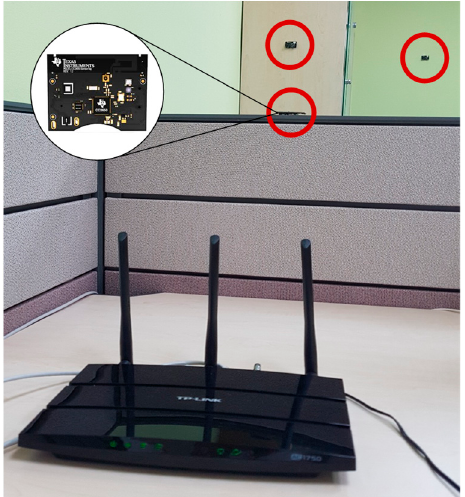
Figure 4. Experimental setup for performance evaluation.